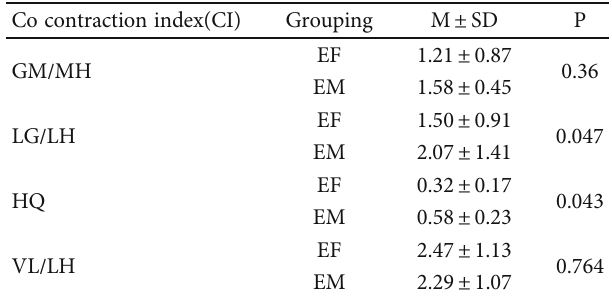
Figure 3: Comparison of muscle contribution rate between CON group and ref group after rehabilitation training. Table 4: Comparison of the common contraction index of each muscle group of the elite male and female soccer players (M ±